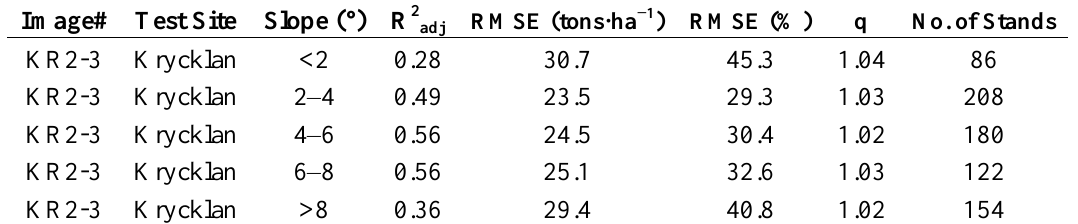
Table 9. Slope class results of AGB at Krycklan.